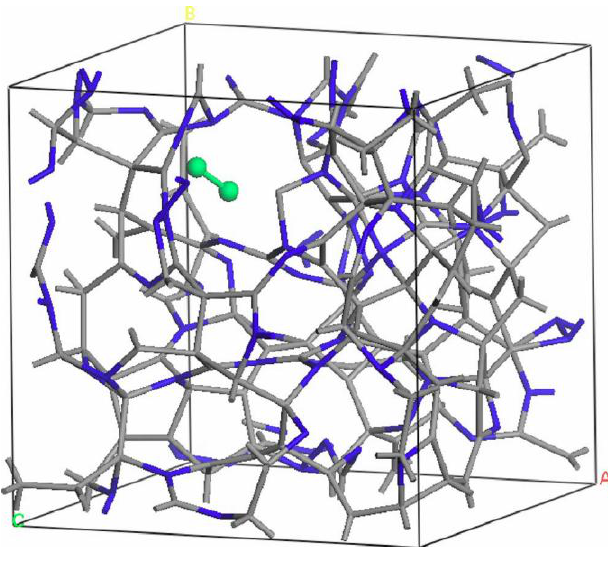
molecule (green dumbbell) appears signaling the saturation limit to nitrogen incorporation. Carbon: light gray sticks; nitrogen: blue